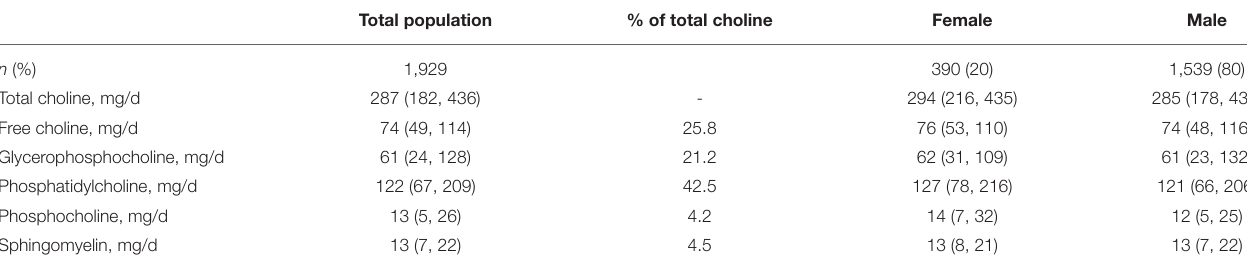
TABLE 4 | Mean energy-adjusted daily reported choline intake in the study population and across